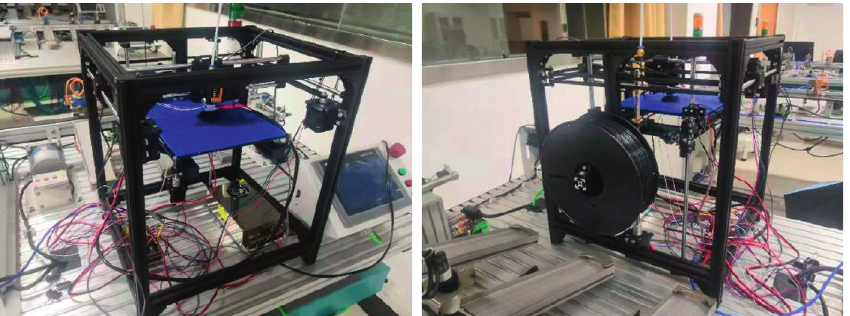
Figure 11: The device of 3D printing.